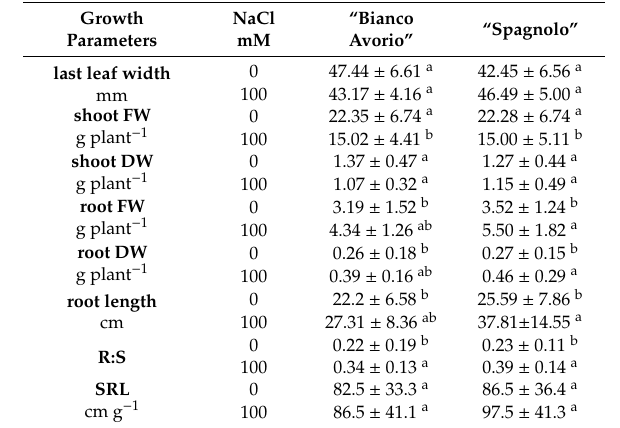
Table 1. Growth-related parameters of “Bianco Avorio” and “Spagnolo” genotypes of Cynara cardunculus var altilis under control (0 mM NaCl) and stress (100 mM NaCl) conditions at the end of the stress period (21 days).